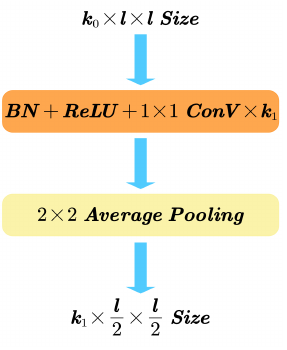
Figure 10. Transition